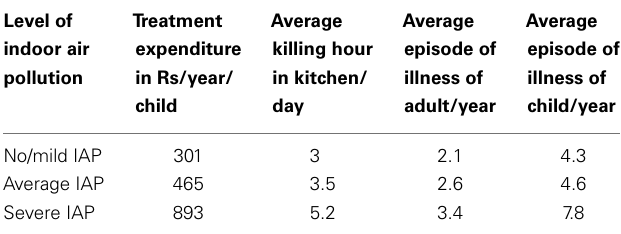
Table 6 | Multiple effects associated with IAP